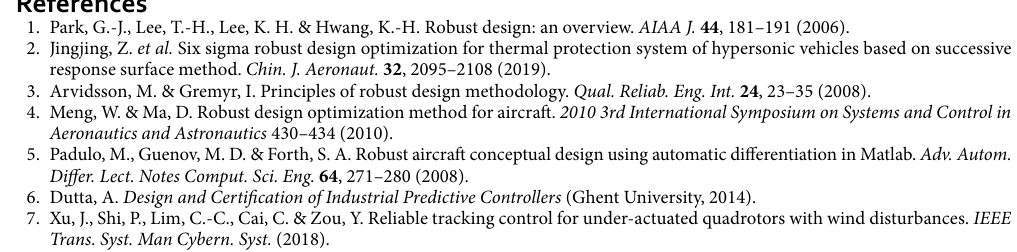
estimators 34 . Otherwise, considering more design parameters including motor or battery power constraints and more accurate aerodynamic representations of the propellers could result in minor improvements.